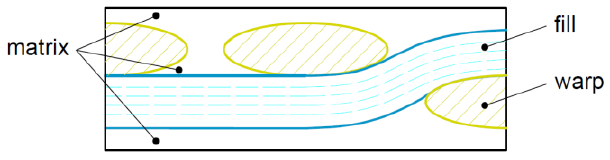
Figure 3. The local layers of a primary element — front view.